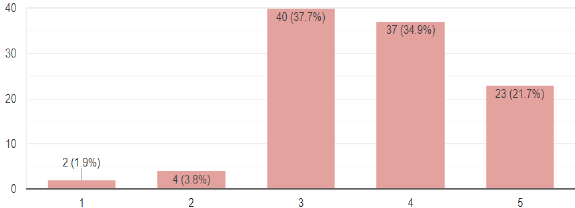
Fig.9. From this, it can be inferred that the majority of people feel mentally healthy.